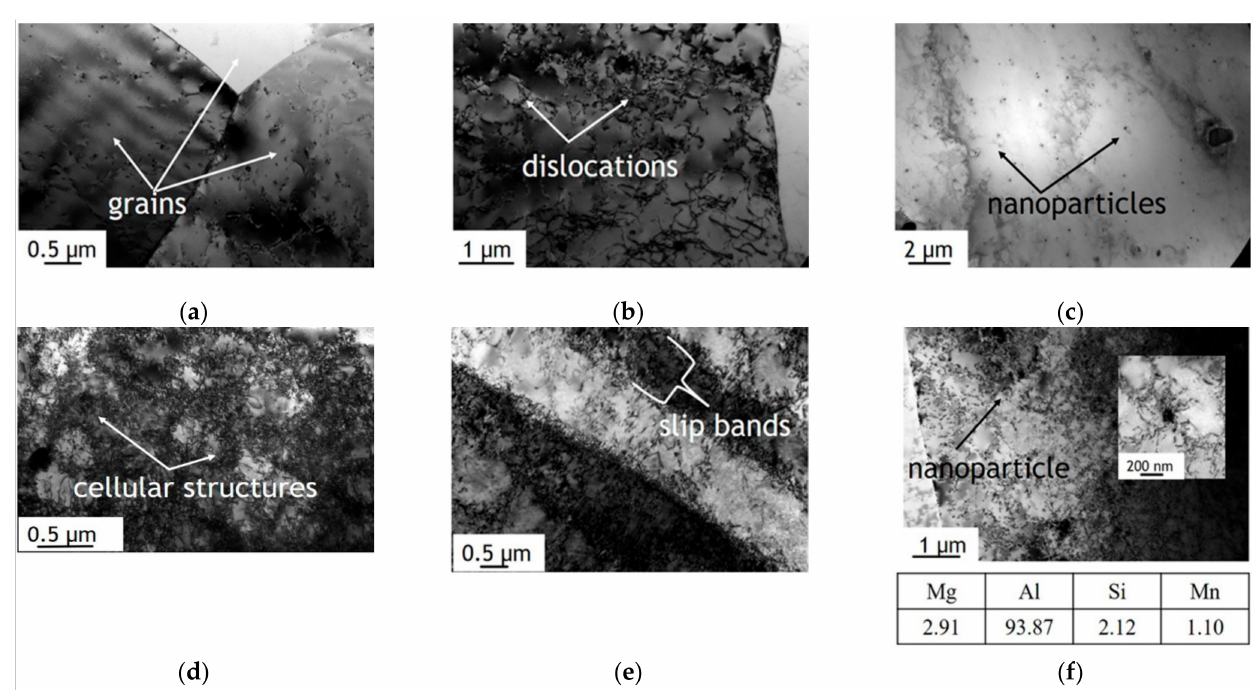
Figure 4. TEM images of the microstructure of the AA5457 sheet in the undeformed area (A): ( a , b ), images showing the overall grain boundaries and dislocation structure, and ( c ), image showing the overall distribution of nanosized intermetallic particles. TEM images of the microstructure of the AA5457 sheet in the deformed area (B): ( d , e ), images showing the increase in the dislocation density and the formation of cellular dislocation structures and slip bands, and ( f ), image showing an increase in the dislocation density around nanosized intermetallic particles. The representative chemical composition of a nanoparticle is presented below panel ( f